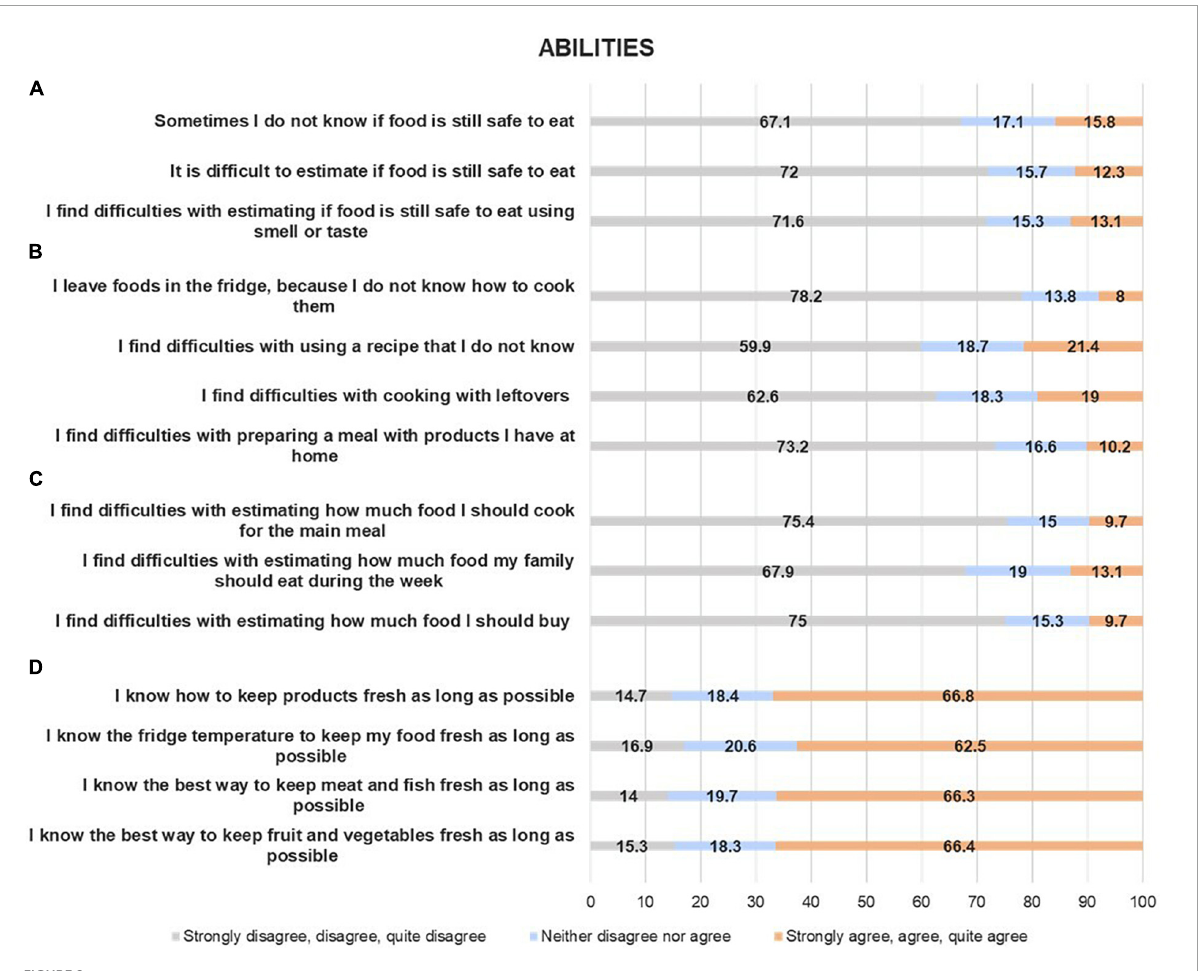
FIGURE2 Food waste abilities among the sample: the perceived difficulty with assessing food safety (A) ; the perceived difficulty with cooking creatively (B) ; the perceived difficulty with accurate planning (C) ; the knowledge of prolonging the shelf-life (D) . Percentage values